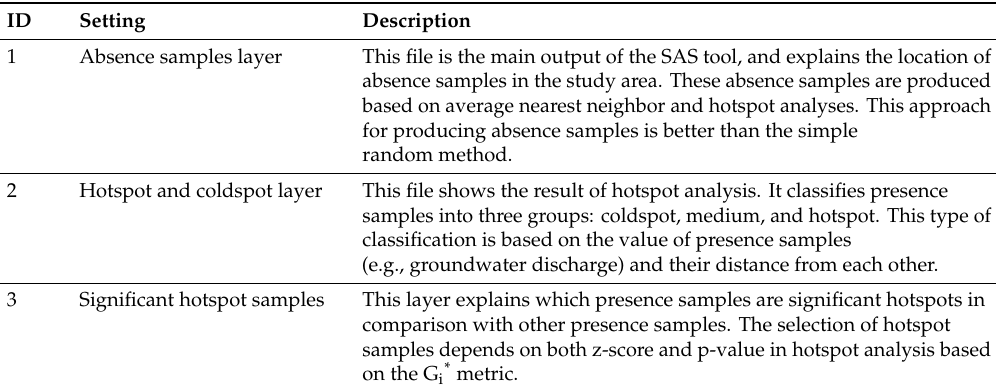
Table 2. Output files of the Selection of Absence Samples (SAS)